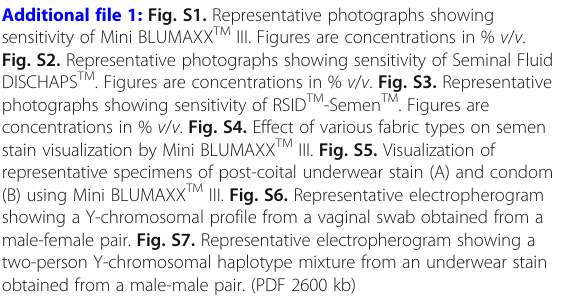
obtained from a male-male pair. (PDF 2600